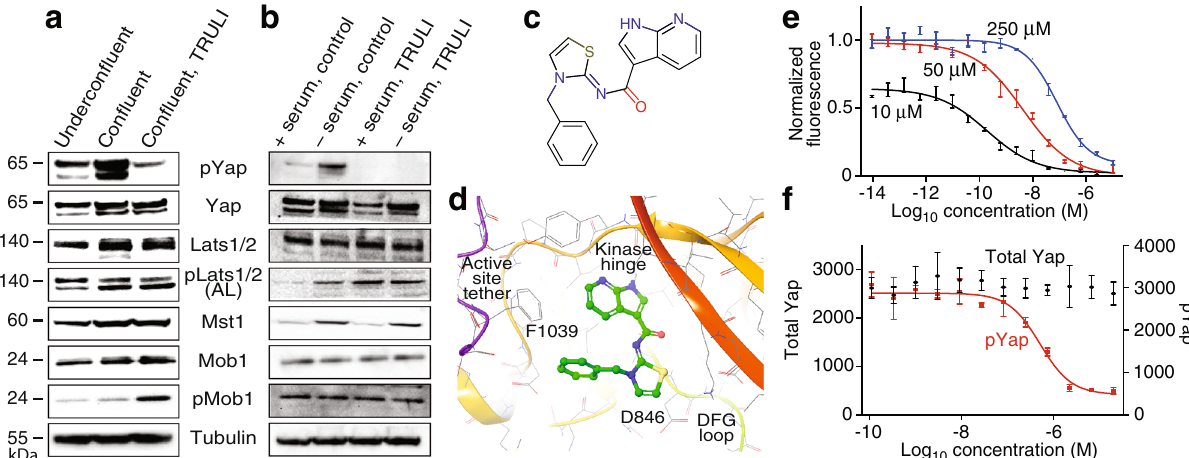
Fig. 3 TRULI inhibits Lats activity in an in vitro kinase assay and prevents Yap phosphorylation in the cell-based assays. a Protein immunoblotting discloses that treatment of MCF 10A cells with TRULI leaves Hippo signaling intact through the activation of Lats kinases, but that Yap phosphorylation is greatly diminished. The experiments were conducted separately three times with the same results. b Serum starvation of HEK293A cells in the presence of TRULI also demonstrates Lats activation but suppression of Yap phosphorylation. The experiments were run separately three times with the same results. c TRULI comprises a thiazolimine backbone with two substituents: a benzyl group and a 7-azaindole hinge-binding motif. d In a simulated structure of TRULI in the predicted ATP-binding site of Lats1, the protein is displayed as a ribbon with heavy atoms in atom-colored wire representation with gray carbons. TRULI is displayed in an atom-colored, ball-and-stick representation. Aspartate 846 is positioned to bind the thiazolimine group and phenylalanine 1039 to interact with the benzyl moiety. e An in vitro assay of Lats1 kinase activity shows that the IC 50 for TRULI increases with the ATP concentration, from 0.2 nM at 10 μ M, to 4.3 nM at 50 μ M, and to 80 nM at 250 μ M, demonstrating that the compound is an ATP-competitive inhibitor. f A kinase assay conducted with serum-starved HEK293A cells indicates an EC 50 of 510 nM for TRULI. Starvation does not signi fi cantly deplete the total amount of Yap. In panels e and f , error bars represent SEMs, and each point represents the mean of three independent samples run in parallel. See also Supplementary Figs. 3 and